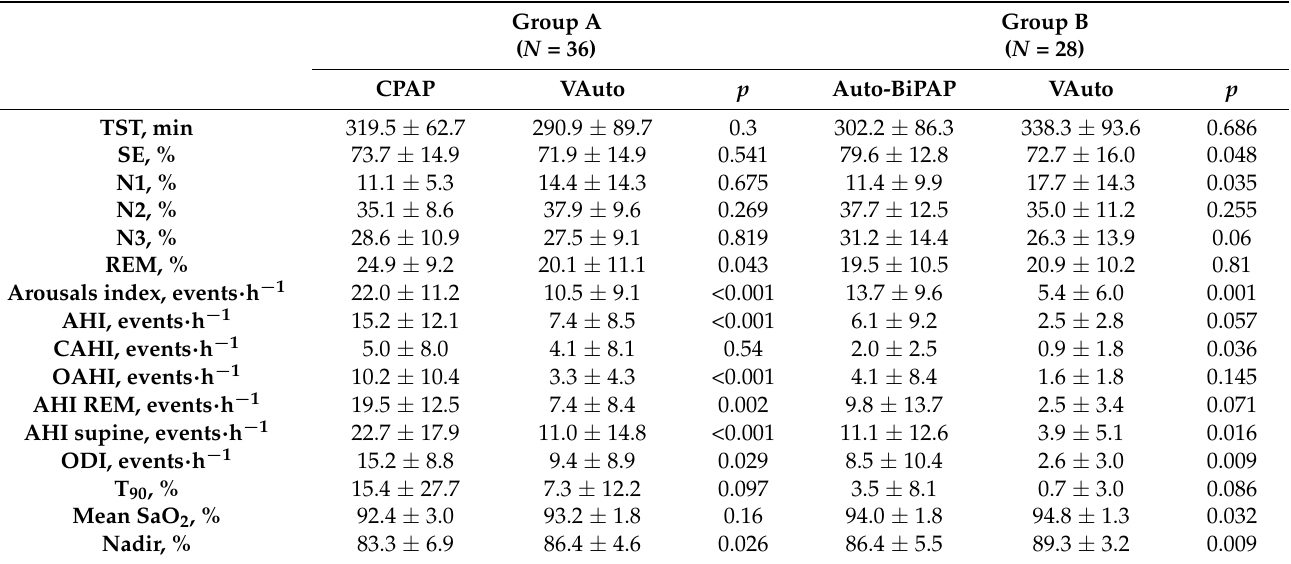
Table 3. Comparison of sleep data in Group A (CPAP vs. VAuto) and in Group B (Auto-BiPAP vs. VAuto).